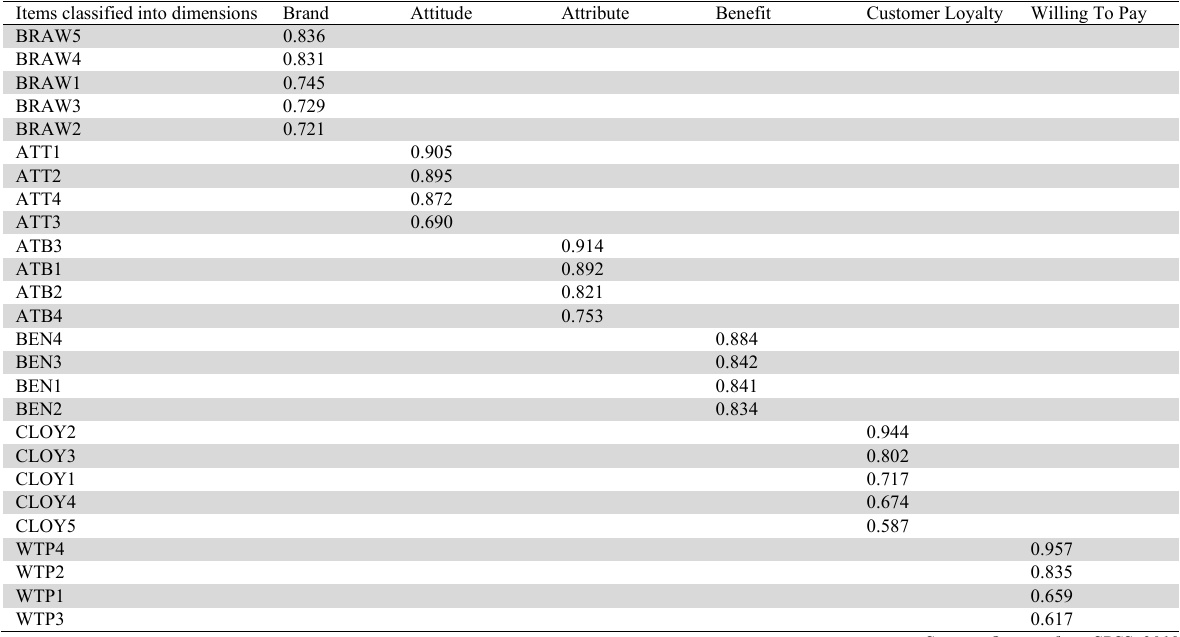
Pattern Matrix Items classified into dimensions